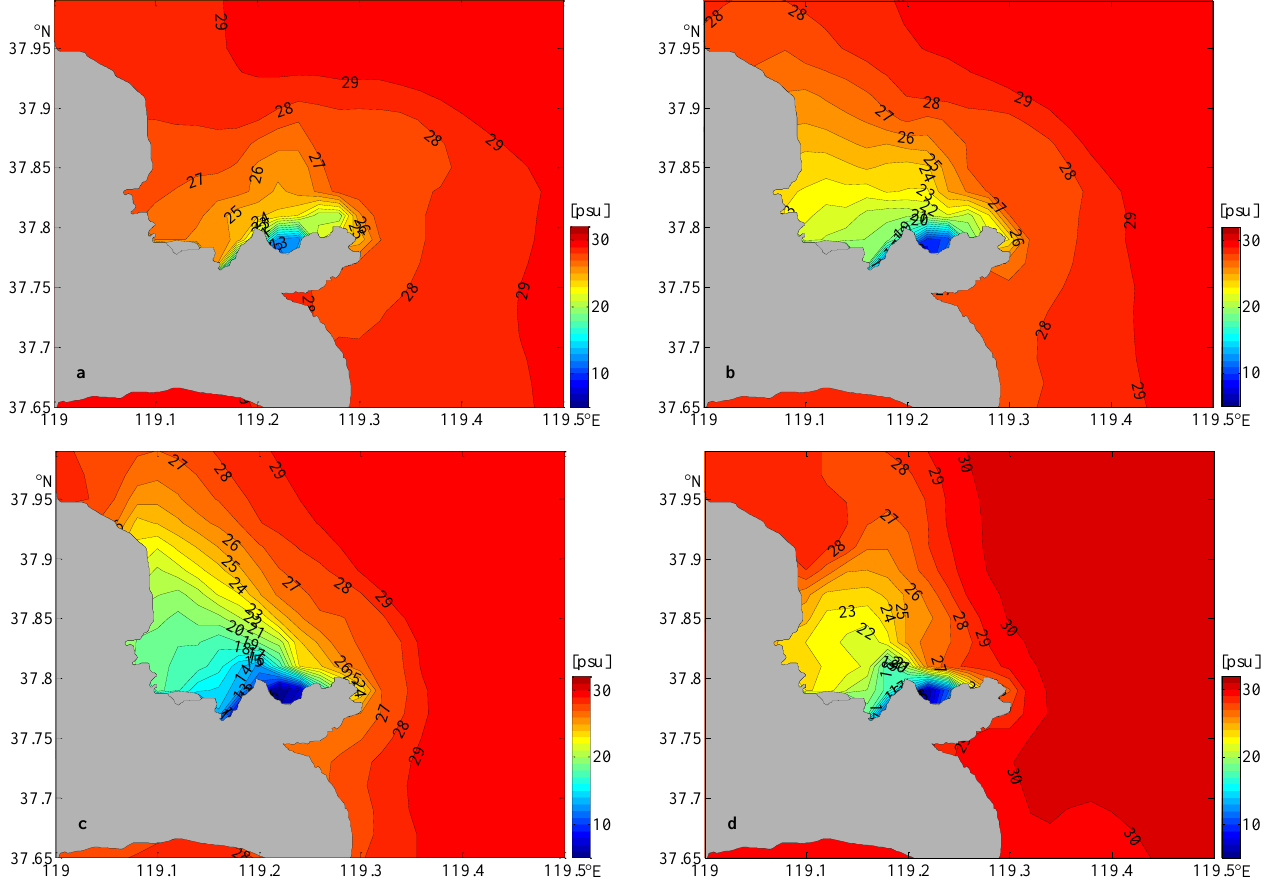
Figure 16. Surface salinity distribution at different wind speeds in the dry season (( a ): case 3, ( b ): case 4, ( c ): case 5, ( d ): case 6).